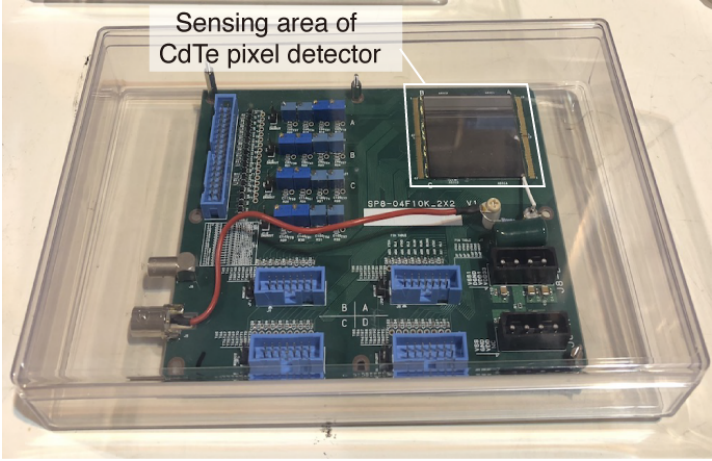
Figure 2. CdTe pixel detector. The sensing area is on the upper-right side of photograph. The CdTe sensor has the Pt/CdTe/Al configuration using a high-resistivity p-type single-crystal CdTe wafer that is 750 µ m thick. The front side (X-ray irradiated side) was processed with a single platinum electrode. The back side was deposited with a 95 × 100 matrix of aluminum